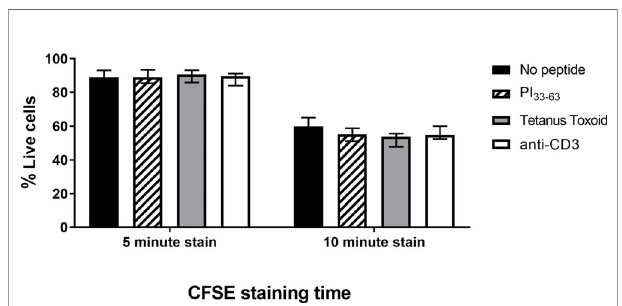
FIGURE 3 | The in fl uence of CFSE staining time on percentage of live cells after 7 days of incubation. Freshly isolated PBMC were stained with CFSE (0.05 µM) for 5 or 10 min and incubated with PI 33-63 (10 µM), tetanus toxoid (10 Lf/ml), or anti-CD3 antibodies (0.1 µg/ml) for 7 days. Median value and range from three technical replicates are shown.